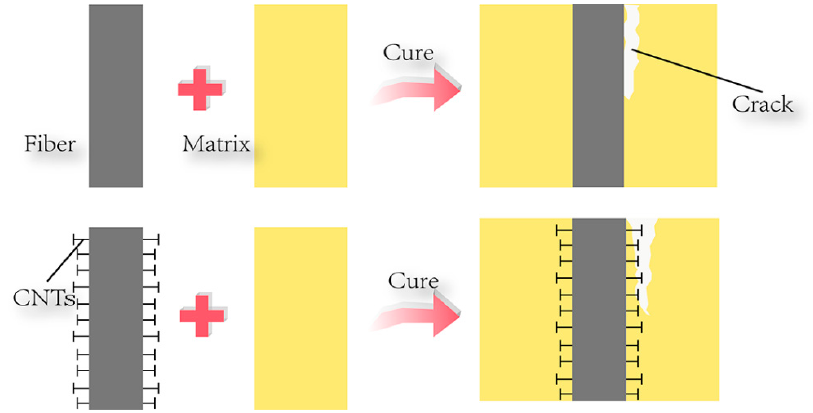
Figure 8. Schema for the differences between pristine and sonicated composites.